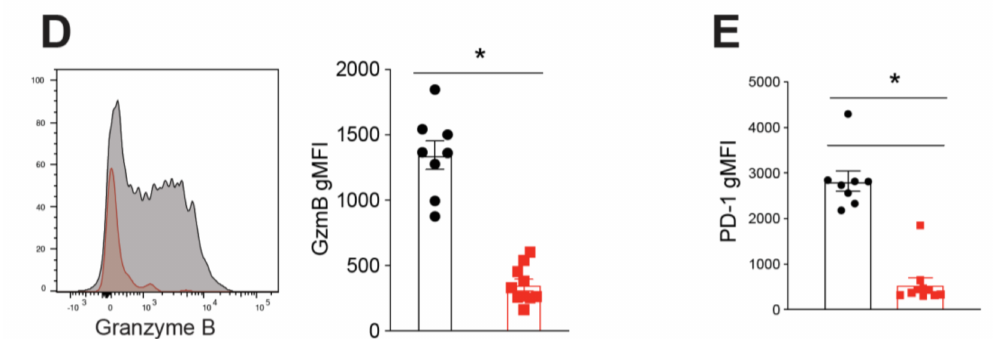
Figure 2. BATF is necessary for endogenous CD8 + T cell differentiation in response to adoptive cell transfer (ACT) of interleukin (IL)-21-producing CD4 + T cells. Mixed bone marrow chimera mice were inoculated with B16-GP33 melanoma. After tumors were palpable, mice were sub-lethally irradiated and adoptively transferred with IL-21-producing CD4 + T cells. Mice were sacrificed after 8 days. ( A ) Tumors were measured to monitor growth following treatment. ( B ) The number of CD8 + T cells/mm 3 of tumor, assessed via cell counts and flow cytometry. ( C ) Frequency of the effector (CX 3 CR1), progenitor (Ly108), and exhausted (double-negative, DN) populations within the activated (CD44 + ) tumor-infiltrating CD8 + T cells, along with representative dot plots. Granzyme B ( D ) and PD-1 ( E ) MFI of activated tumor-infiltrating CD8 + T cells, with representative histograms shown. ( A – E , n = 8–10 mice per group). (* p -value <